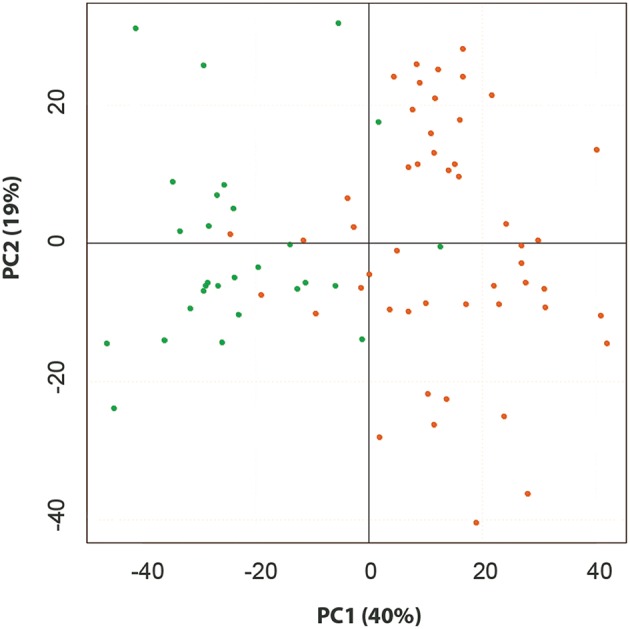
Scores plot from PCA of the near-infrared spectra of 11 sorghum lines. Data from NIRS were averaged (n = 5–8 per line). Biomass types are shown with green symbols and grain types with brown symbols.